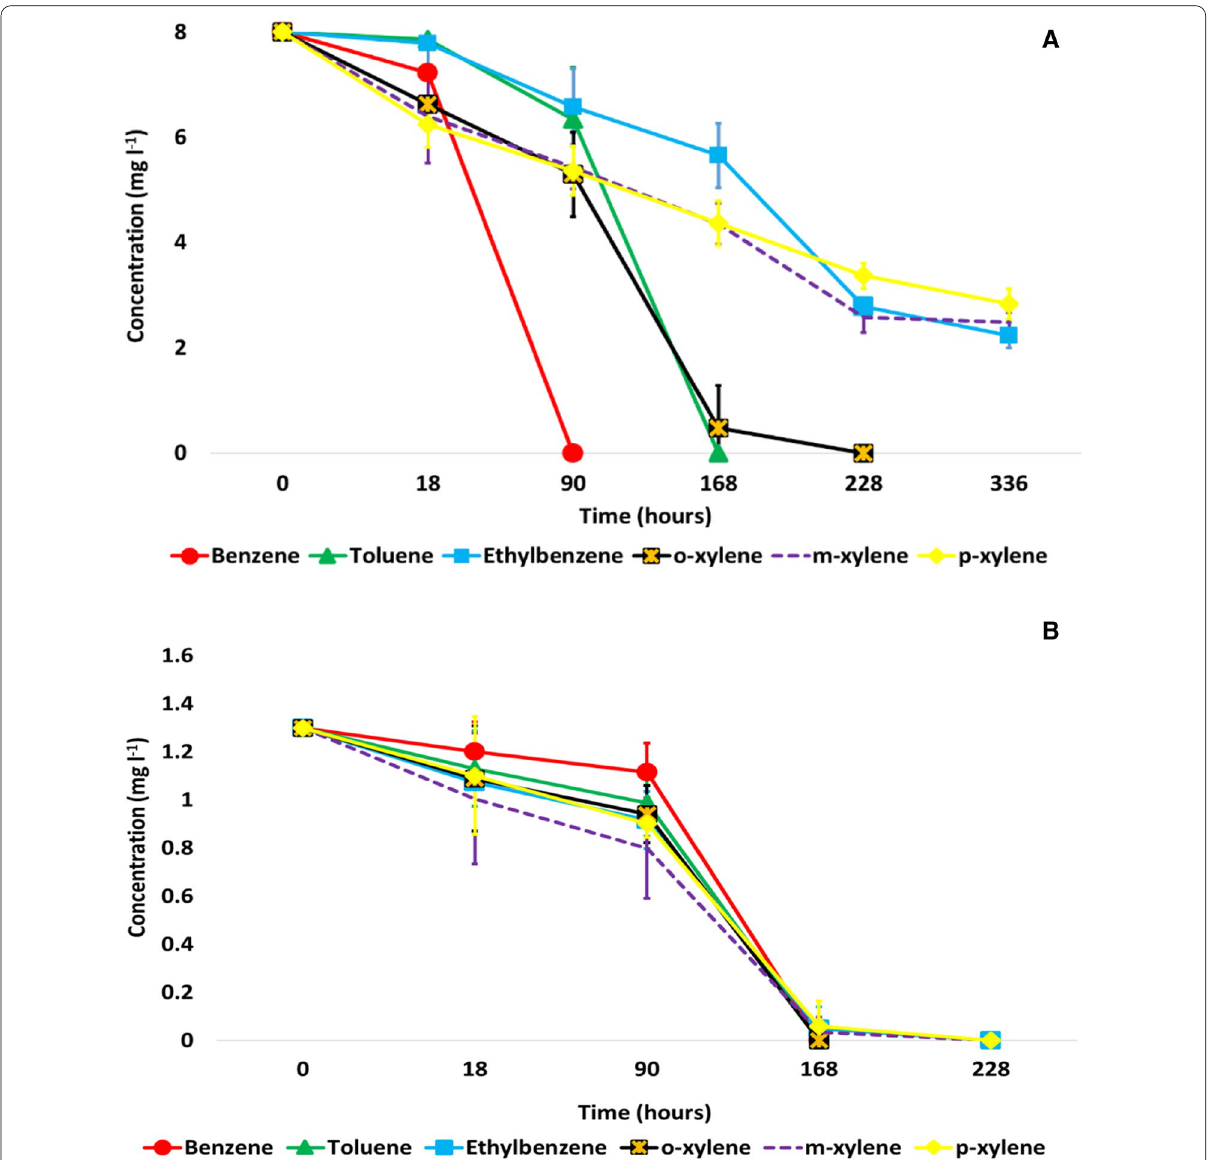
Fig. 2 Individual ( A ) and BTEX mixture ( B ) degradation ability of V. paradoxus strain BFB1_13 under aerobic